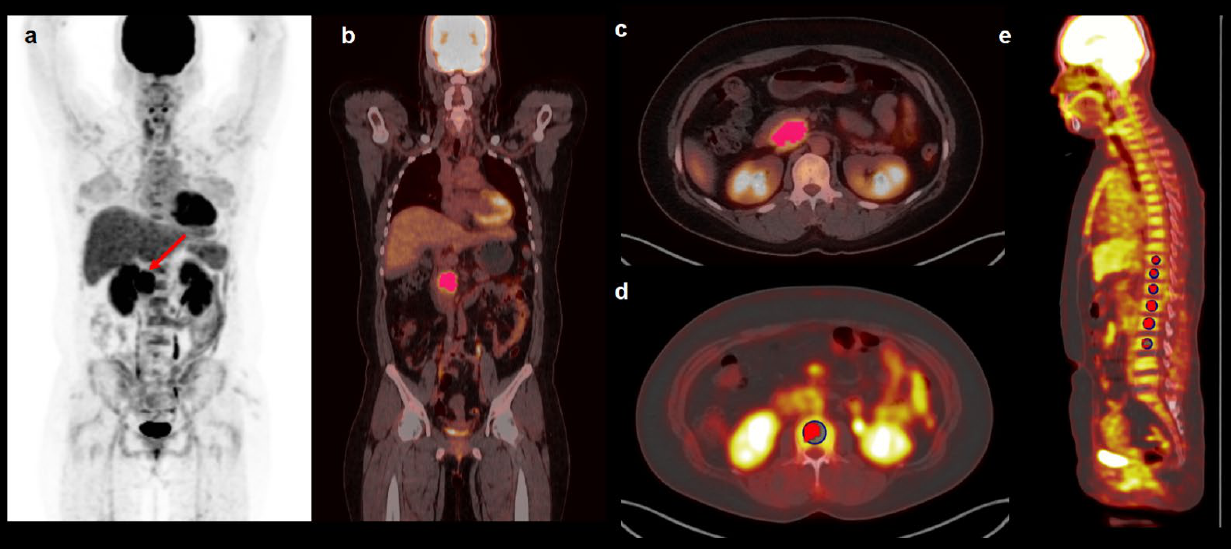
Figure 1. Maximal intensity projection image ( a ), coronary image ( b ), transaxial images ( c , d ), and sagittal image ( e ) of FDG PET/CT showing an example of VOIs for measuring imaging features of pancreatic cancer and FDG uptake of BM. A 43-year-old woman underwent FDG PET/CT for staging work-up of pancreatic cancer with a maximum SUV of 9.55 (arrow on a ). To delineate pancreatic cancer lesion, a VOI was manually drawn around the primary tumor, and an area that showed SUV higher than the threshold value of 4.22 determined by Nestle’s adaptive threshold method was selected within the VOI (pink color in b , c ). To measure FDG uptake of BM, six spheroidal VOIs were drawn over the vertebral body of the thoracic and lumbar spine, and an isocontour using a cutoff SUV of 75% of the maximum SUV was automatically generated within each VOI (red color in d and e ). Mean SUV of voxels within the isocontour was measured and defined as BM SUV.